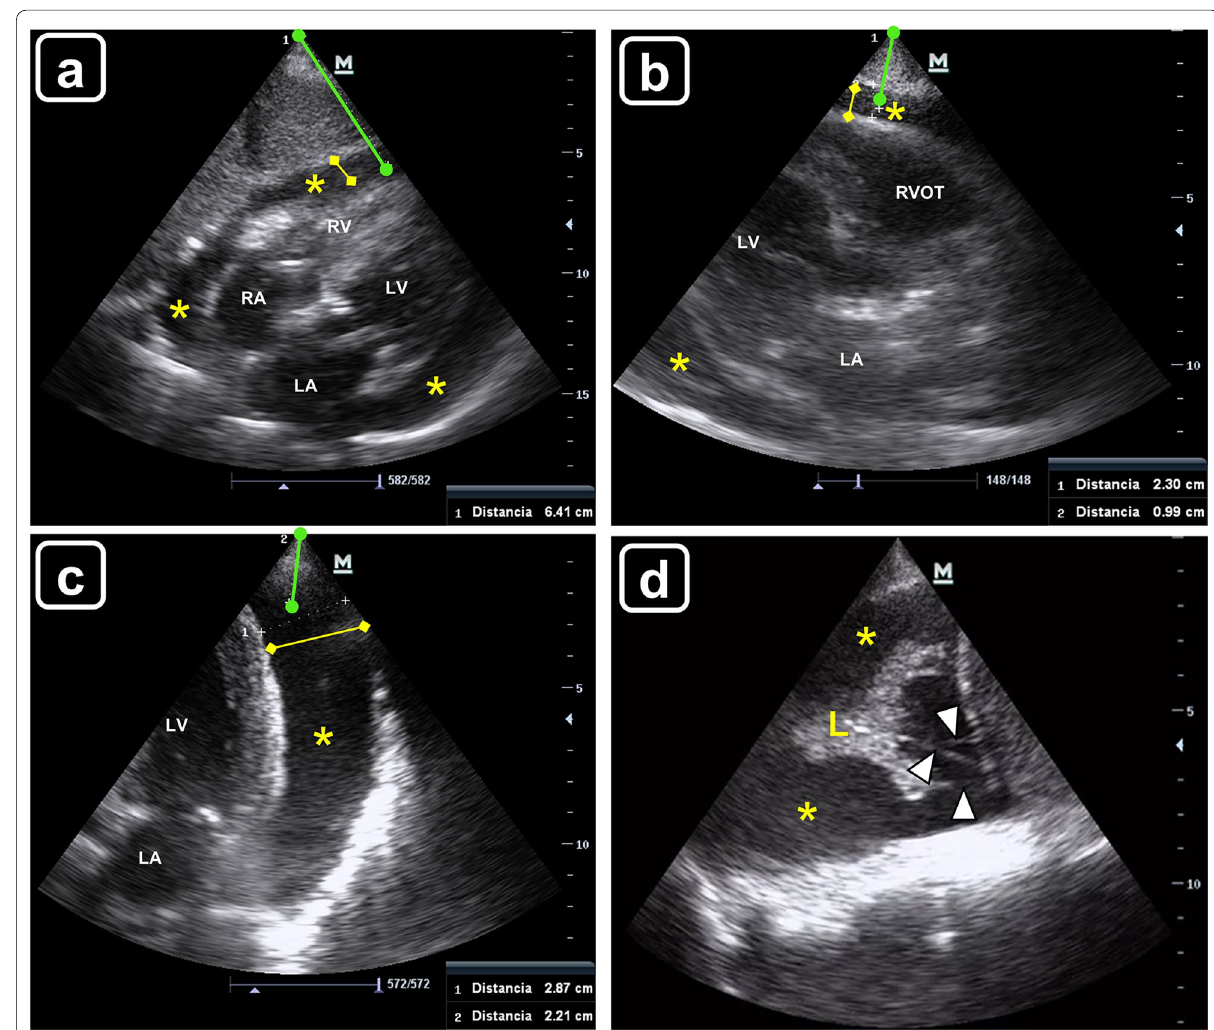
Fig. 1 Point-of-care echocardiogram showing the circumferential pericardial effusion (asterisks), the pericardial fluid thickness (yellow line) and the distance to reach the pericardial cavity from the skin (green line); a subcostal four chamber view, b parasternal long axis view, c apical four chamber view, RA right atrium; RV right ventricle; LA left atrium; LV left ventricle; RVOT right ventricular outflow tract. d Left-sided pleural effusion (asterisks) with fibrin strands (arrowheads); L lung